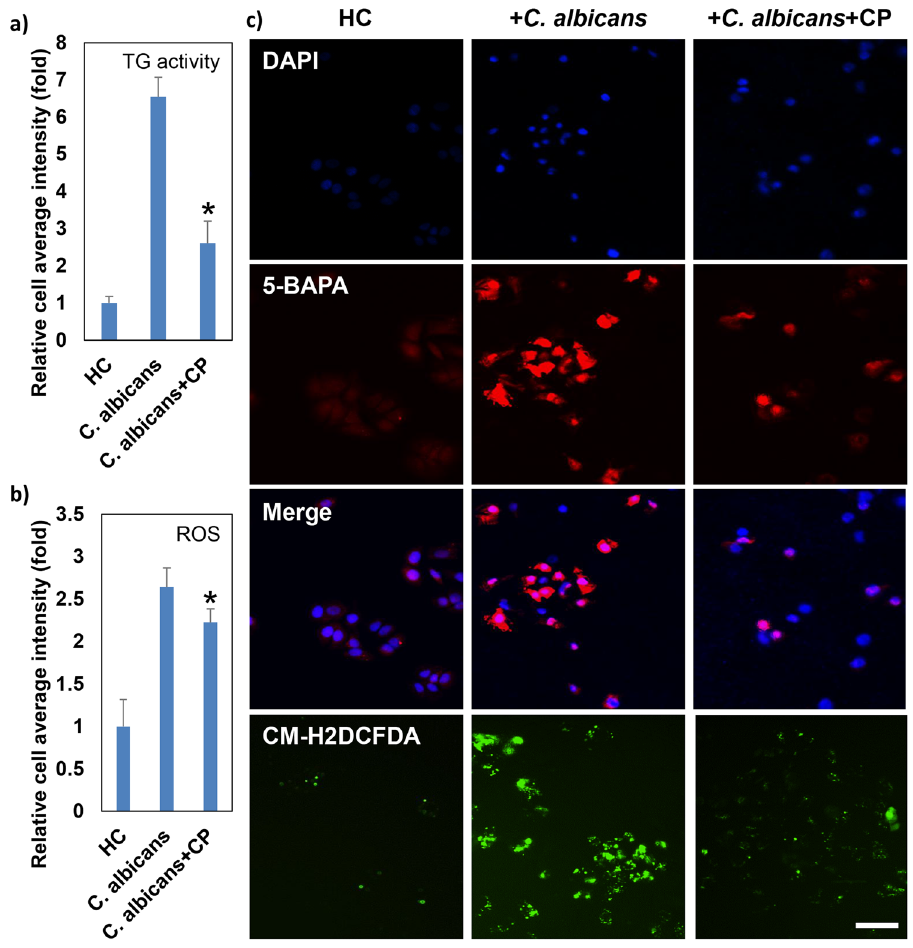
Figure 4. Antioxidant corn peptide fraction inhibits C. albicans -induced TG activity in HC cells. HC cells were seeded at 1 × 10 4 cells per well in a 96-well plate and were incubated overnight as previously described. Cells were incubated alone (HC) or were co-incubated with 1 × 10 6 C. albicans cells ( C. albicans ) in the presence of 100 μ g/mL corn peptide fraction ( C. albicans + CP). ( a ) TG activity in the cells was detected by 5-BAPA incorporation, as previously described. After 24 hours, cells were fixed and stained with streptavidin-TRITC and 4 ′ ,6-diamidino-2-phenylindole (DAPI) dye. Both the blue fluorescence signals from DAPI-stained nuclei and the red fluorescence signals representing TG activity were detected with the ImageXpress MICRO High Content Screening System, and morphological analysis was performed using MetaXpress Image Analysis software. ( b ) After 24 hours, cells were incubated with 5 µ M CM-H2DCFDA for ROS detection. Green fluorescence signals from CM-H2DCFDA representing ROS were observed with the ImageXpress MICRO High Content Screening System (Molecular Devices, Sunnyvale, CA, USA), and morphological analysis was performed using MetaXpress Image Analysis software (Molecular Devices). The representative quantitative data are presented as the mean ± SD of at least three replicates from two independent experiments. ( c ) Representative fluorescence images from at least 4 fields from more than three samples of two independent experiments. Scale bar = 50 μ